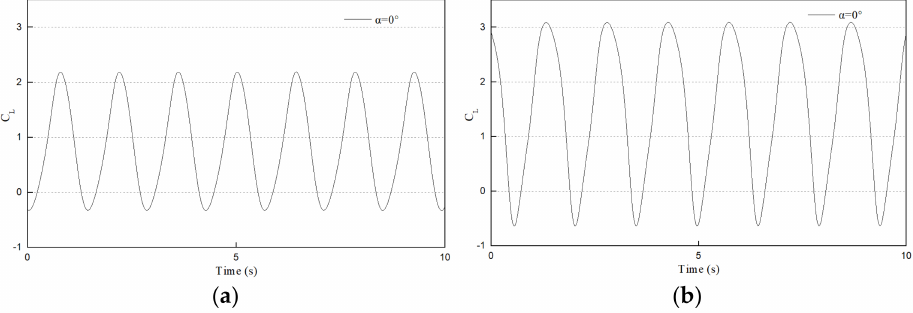
Figure 26. Distribution diagrams of C L flow around a circular-ended pier: ( a ) α = 30 ◦ ; ( b ) α = 45 ◦